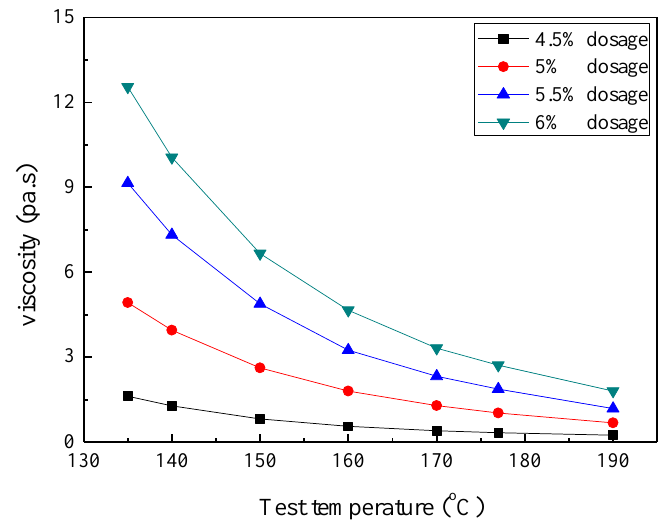
Figure 5. Rotary viscosity of asphalt binder. 195